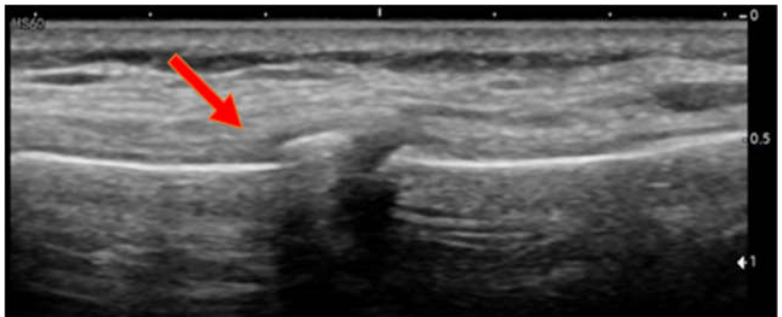
Figure 3. Case 3, fracture 1st sternebra caudal.